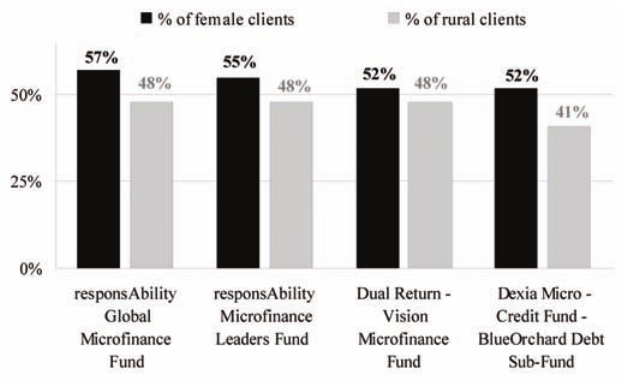
Fig. 3. The Share of Female and Urban